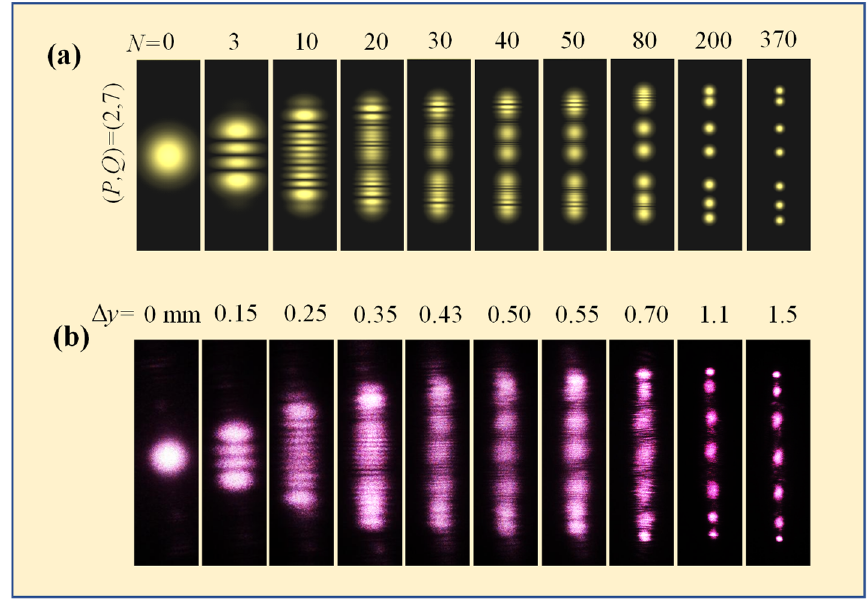
(cid:12) (cid:12) 2 φ = , Ψ + (cid:12) (cid:12) ( (cid:101) x , (cid:101) y , (cid:101) z = 20 ) with P / Q = 2/7, φ y = 0, y (cid:12) (cid:12) 0, N